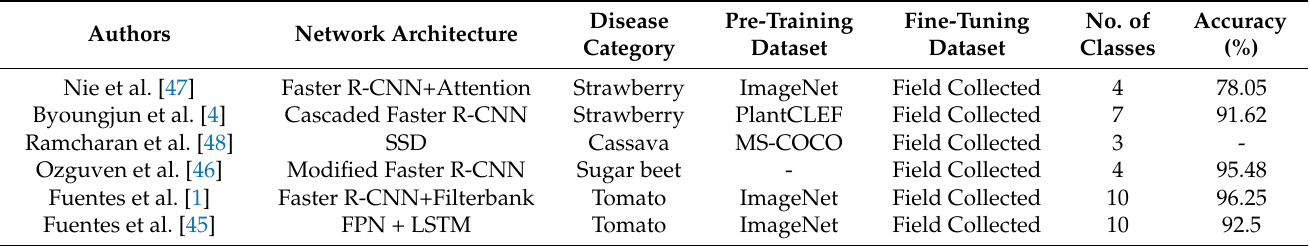
Table 2. Object detection-based approaches for plant disease